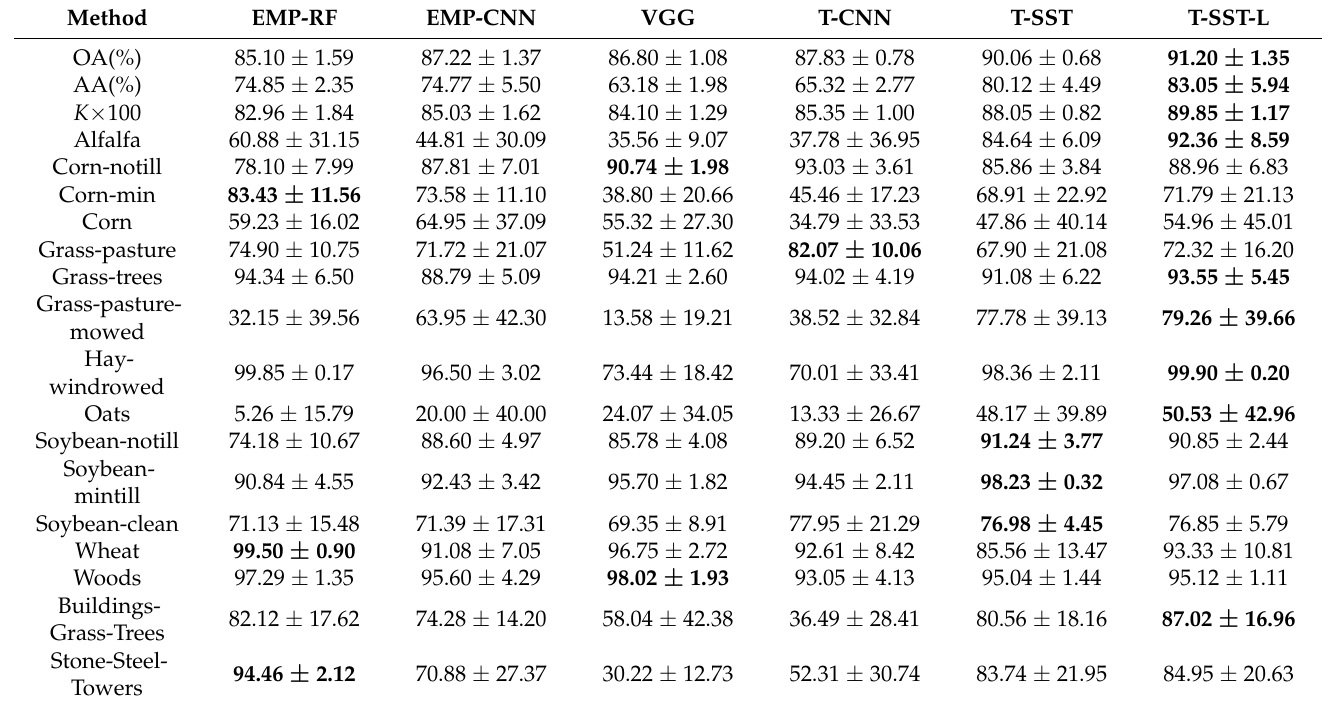
Table 7. Test accuracy with different preprocessing methods on the Indian Pines dataset.